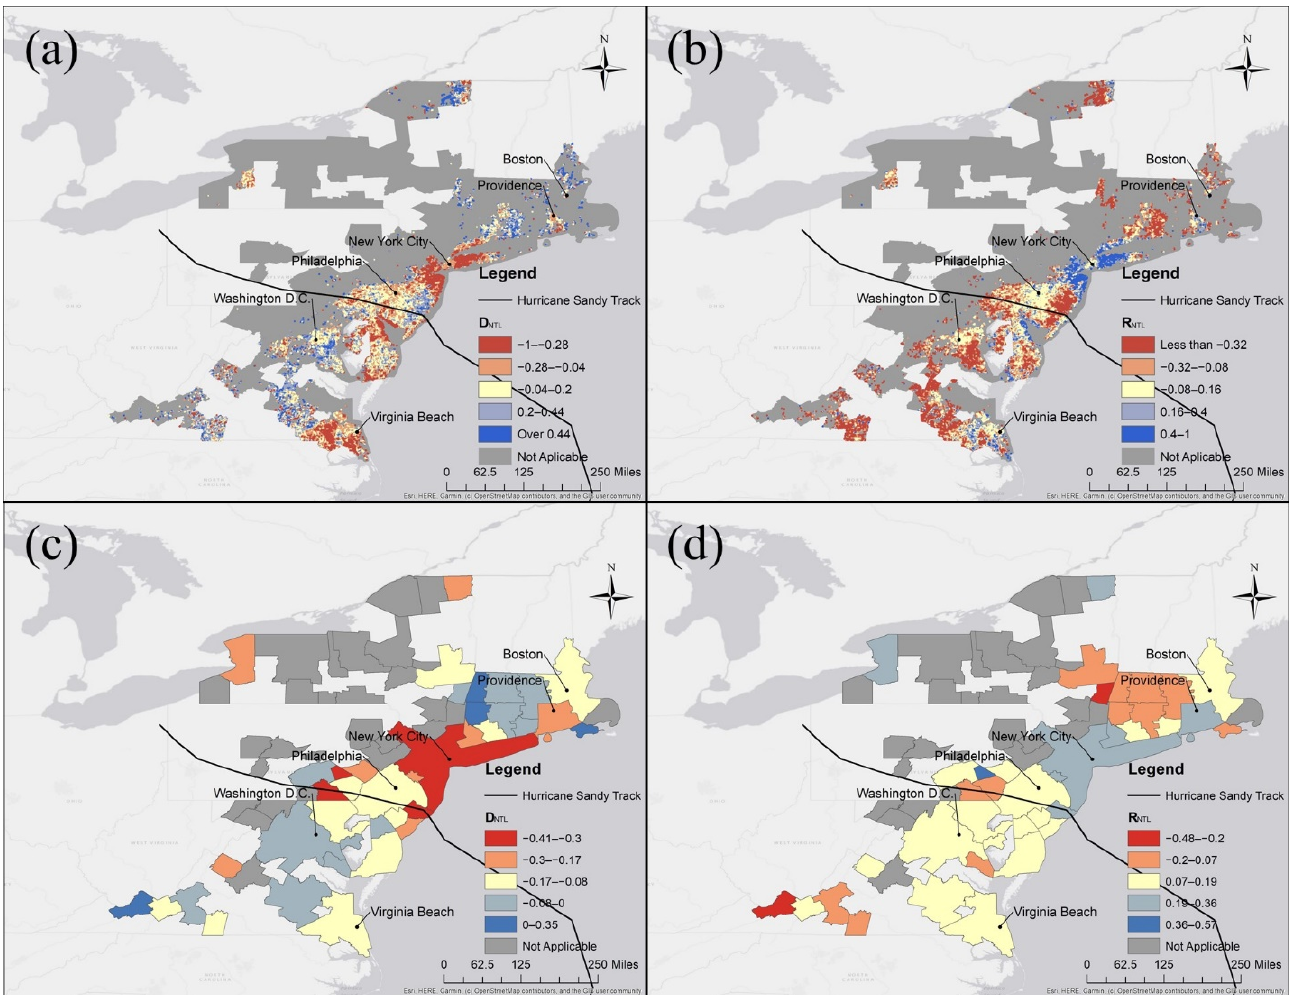
Figure 9. Choropleth maps of NTL fluctuation in Hurricane Sandy (2012) in the Northeastern US: ( a ) D NTL by pixel; ( b ) R NTL by pixel; ( c ) D NTL by CBSA; ( d ) R NTL by